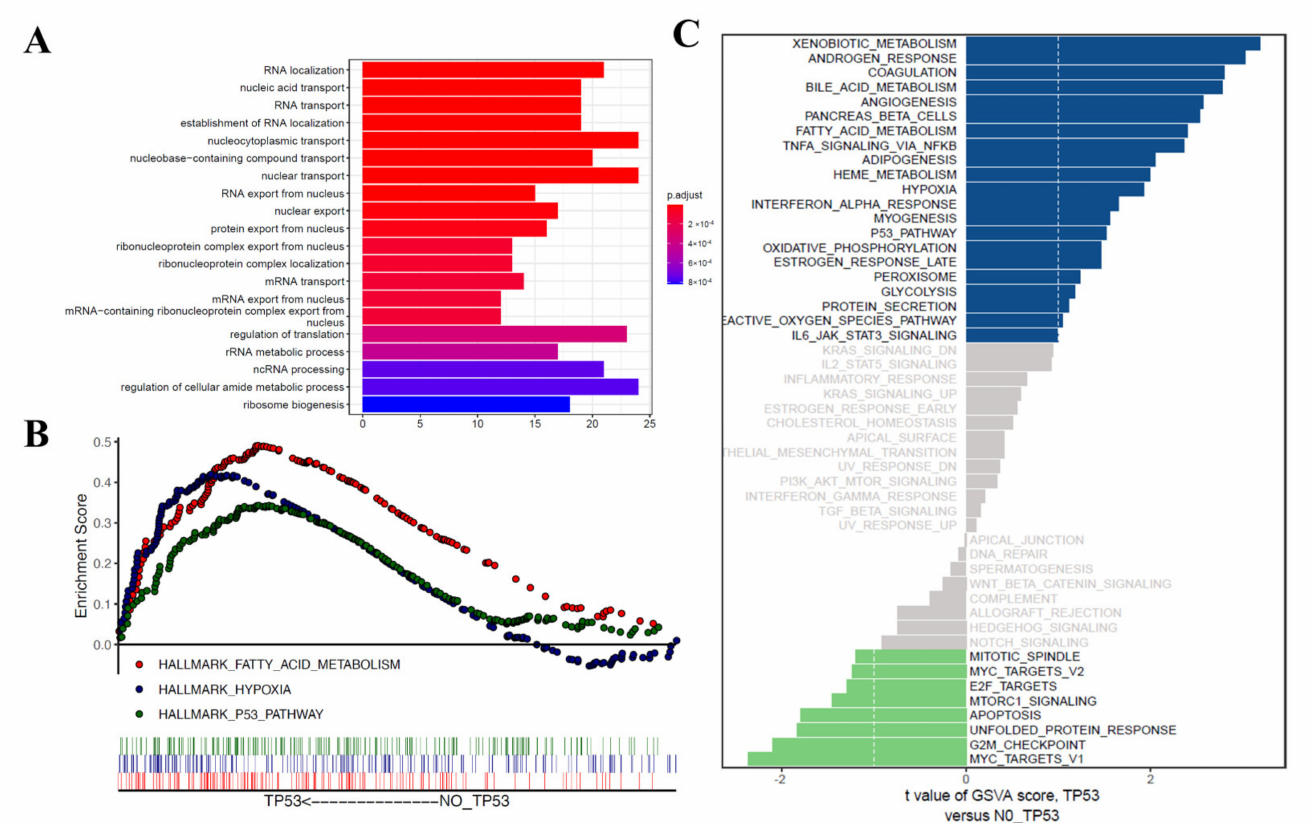
Figure 4. GO, GSEA, and GSVA analyses. ( A ) Significantly enriched gene ontology terms in categories BP. ( B ) GSEA analysis based on h.all.v7.1.symbols.gmt. ( C ) GSVA analysis based on h.all.v7.1.symbols.gmt. GO: Gene ontology; GSEA: gene set enrichment analysis; GSVA: gene